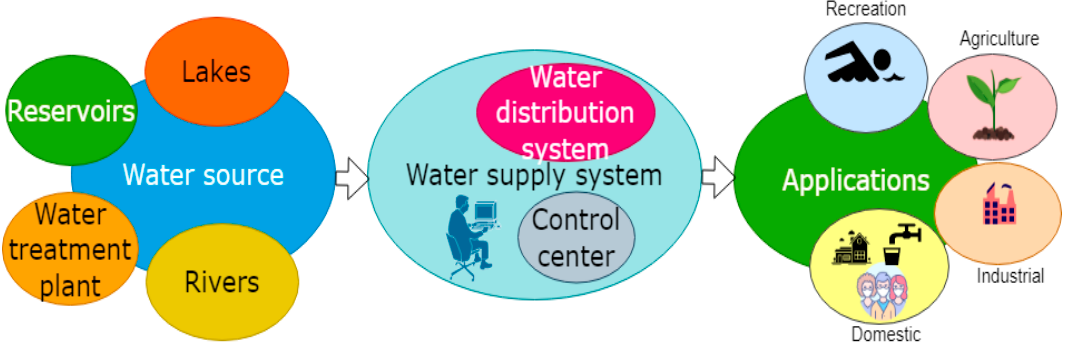
Figure 5. A typical illustration of an IoWT network [51].